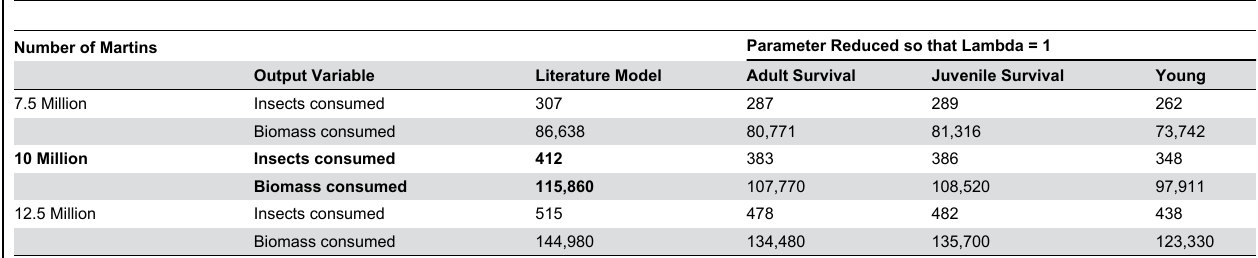
Table 3. Projected number (billions) and biomass (tonnes) of insects consumed by Purple Martin populations annually.